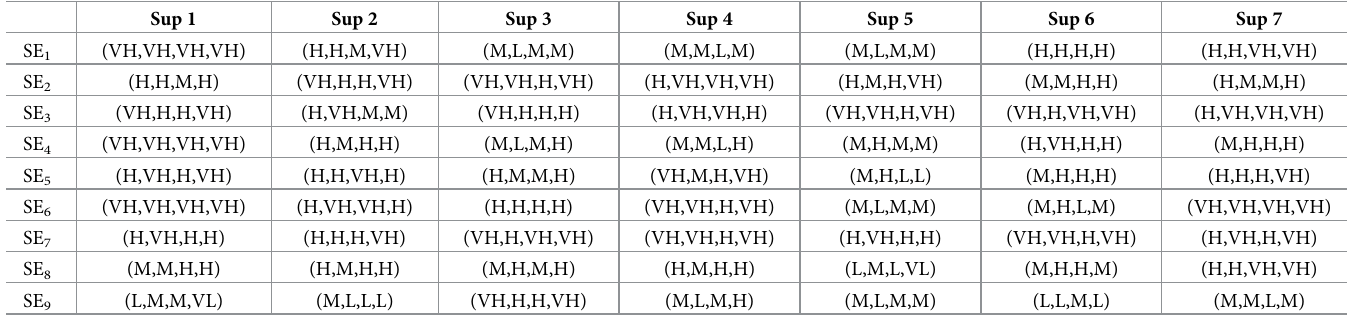
Table 7. Linguistic ratings of suppliers with respect to SEs. Sup 1